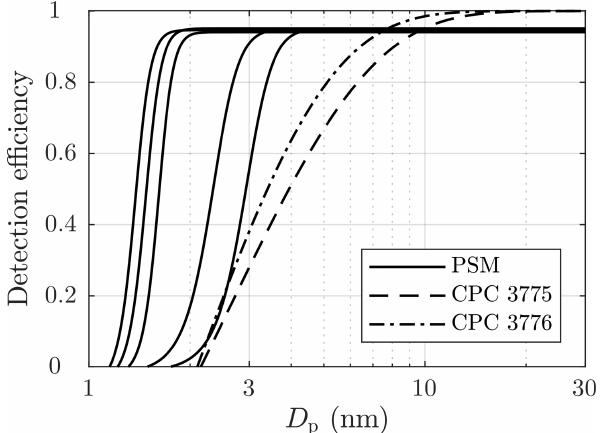
Figure 3. The dilution ratio of the bridge diluter with different par- ticle